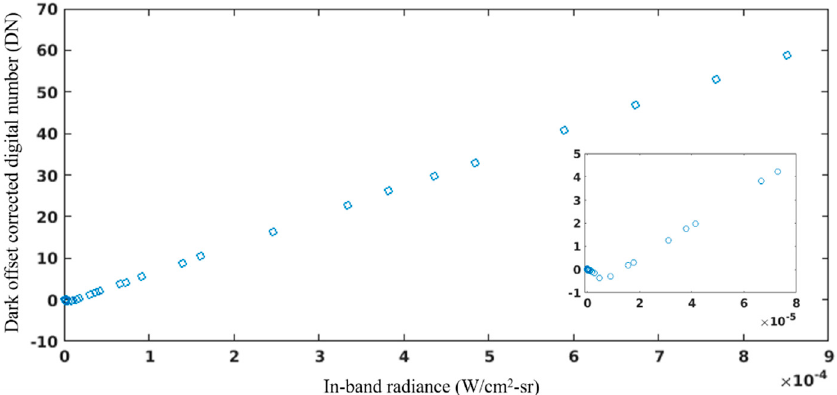
Figure 6. NOAA-20 VIIRS DNB LGS radiometric response (dark offset corrected digital number) at low radiance levels evaluated by using the prelaunch test data. Data for aggregation mode 21, detector 1 and HAM side A are shown. The inset shows the response curve near the origin.